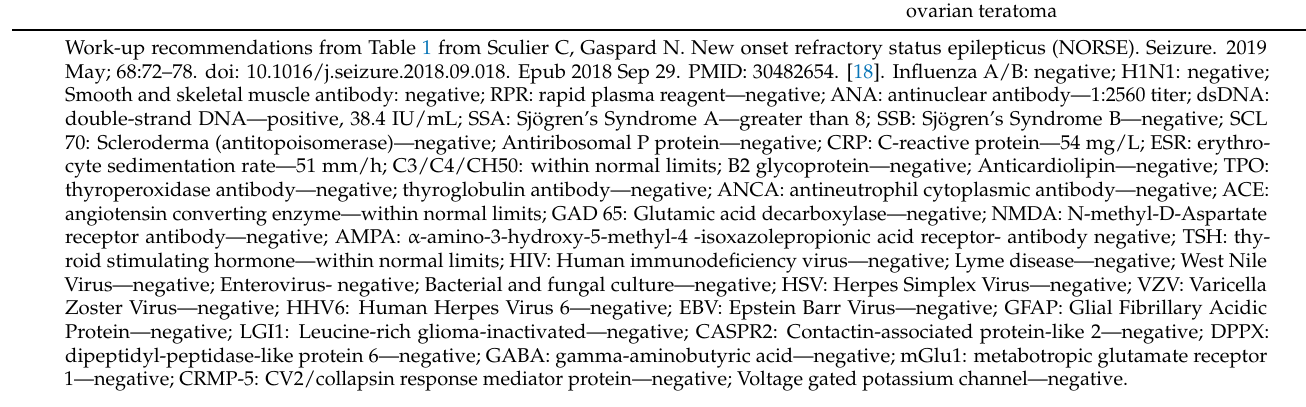
US pelvis: tiny 3–4 mm echogenic focus on the left